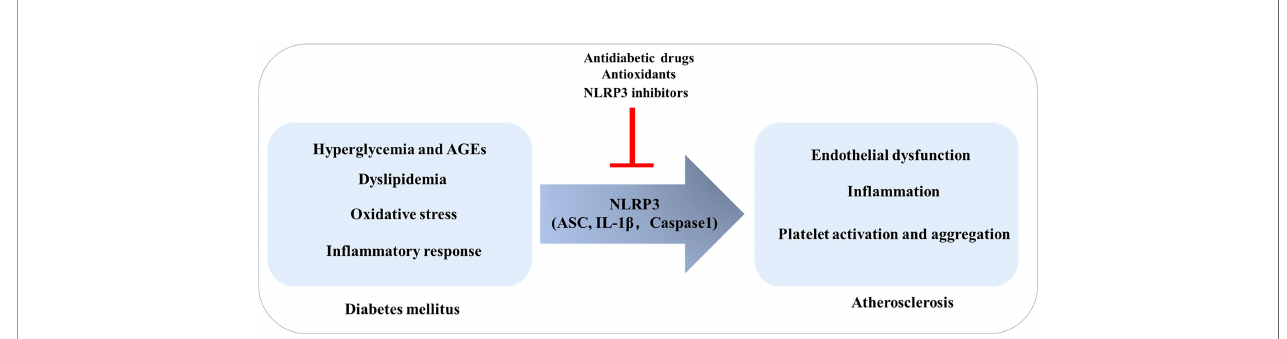
FIGURE 2 | Diabetes Mellitus promotes the development of atherosclerosis: the role of NLRP3. In the context of diabetes mellitus, risk factors such as high glucose, oxidative stress, and in fl ammation can induce endothelial dysfunction, in fl ammation, and platelet activation and aggregation by regulating NLRP3 in fl ammasome, thereby